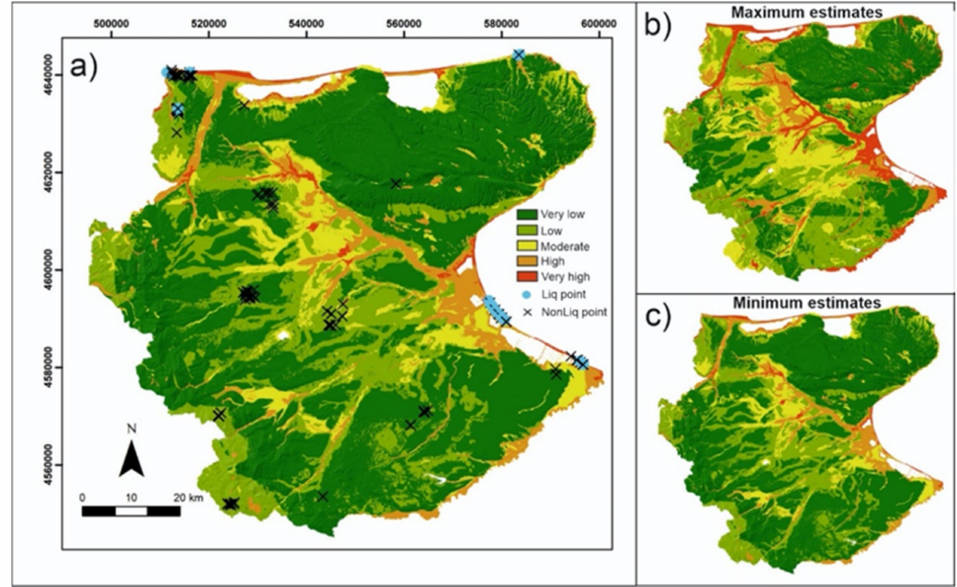
Figure 5. Liquefaction susceptibility map ( a ) with the related maximum ( b ) and minimum ( c ) es- timates. Distribution of liquefaction and non-liquefaction points used for cross-validation is also reported in ( a